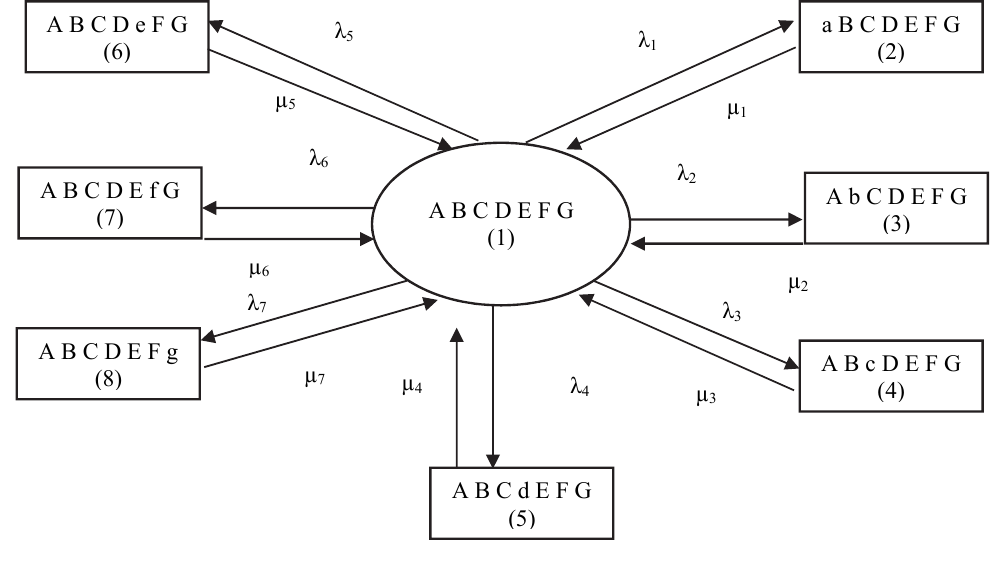
Fig. 2. State transition diagram of CSDGB filling system of a beverage